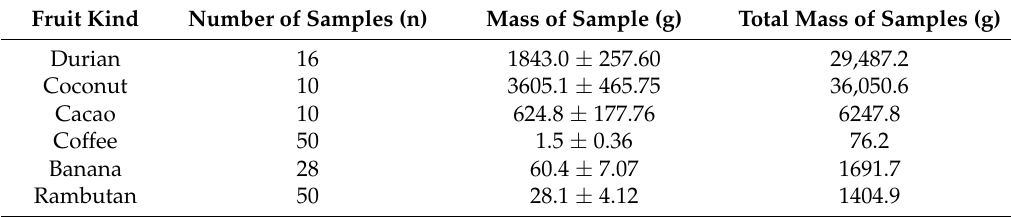
Table 1. Mass of investigated unprocessed fruit samples.